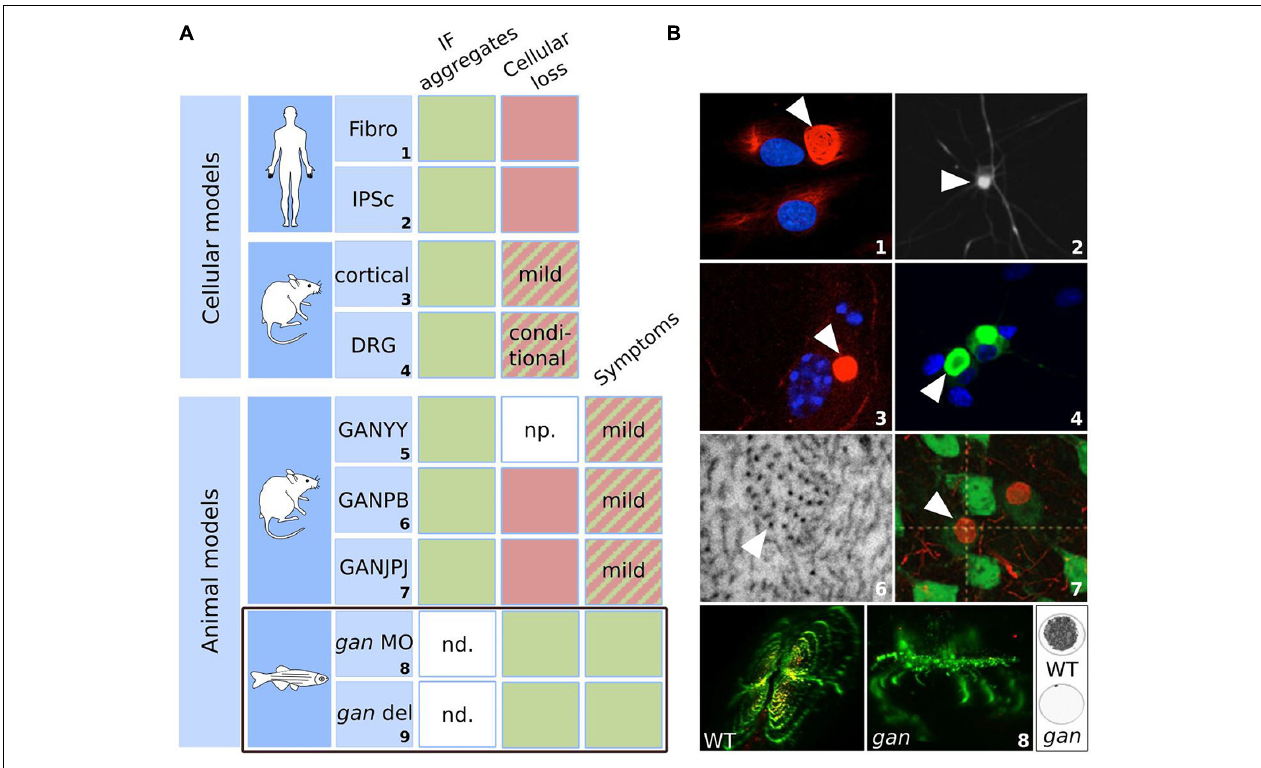
FIGURE 6 | Biological models for GAN: strengths and weaknesses. Summary table (A) and illustrations (B) of the cellular and animal models developed for GAN. The table highlights their ability to reproduce the cellular marker and symptoms of the pathology. Green: the model satisfies the criteria; red: the model does not meet the criteria; hatched: the model partially satisfies the criteria. IF aggregation is evidenced in all cellular and animal models. Cellular loss was observed in aging GAN cortical neurons and upon specific conditions in DRG neurons. While GAN mice exhibit only modest symptoms, the gan zebrafish stands out as the first robust animal model for GAN, reproducing both neuronal loss and loss of motility, as in patients. np. not provided; nd: not determined. gan MO: transient repression using morpholino antisense oligonucleotide; gan del: genetic deletion mutant of gan . Numbers correspond to original publications: 1 : patient fibroblasts with bundling of vimentin (Pena, 1981; Bomont and Koenig, 2003); 2 : iPSC-derived motor neurons from GAN patients exhibiting peripherin aggregation (Johnson-Kerner et al., 2015a); 3 : GAN − / − cortical neurons showing NF aggregate (Bomont: personal data). 4 : GAN DRG neurons with accumulations of α -internexin (Israeli et al., 2016); 5 : GAN1 (cid:49) ex3 − 5 (Ding et al., 2006); 6 : Electron micrograph of the axoplasm of GAN2 (cid:49) ex3 − 5 nerves (Ganay et al., 2011), showing abnormal packing and orientation